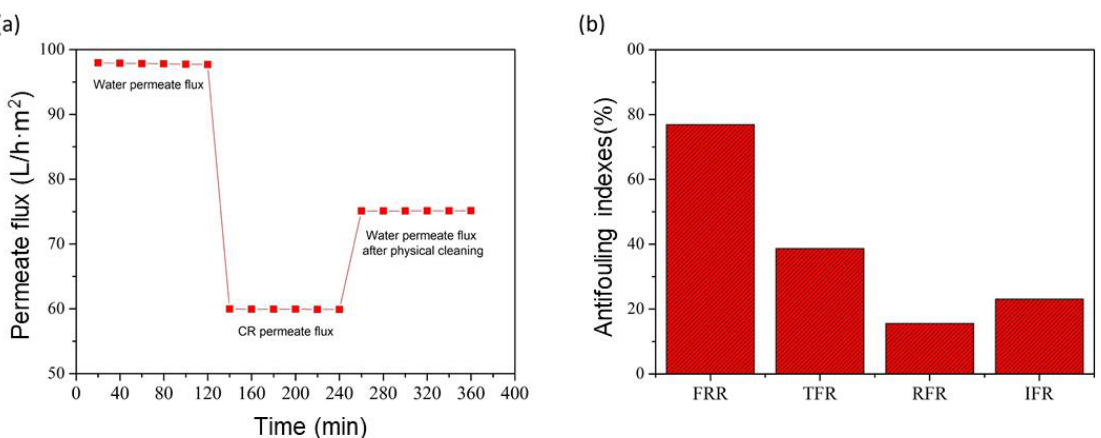
Figure 12. ( a ) Permeate flux during the filtration experiments; ( b ) antifouling indexes of the GO/phosphate membrane.